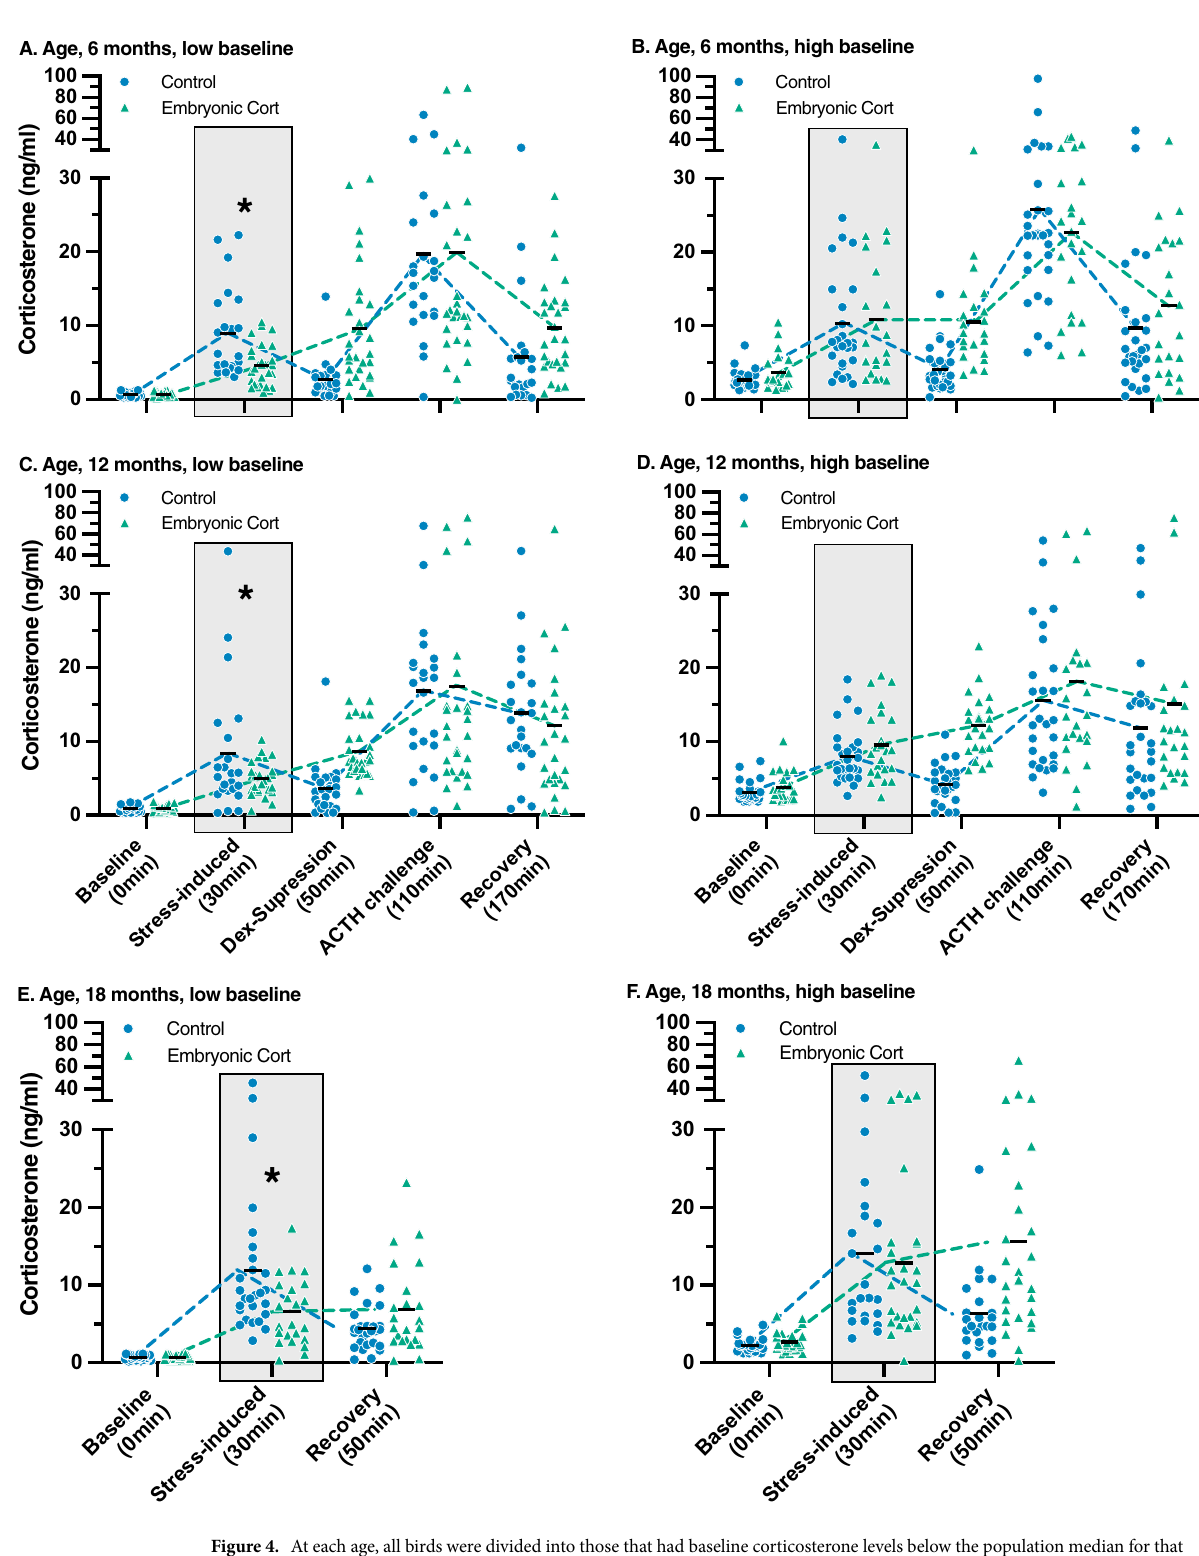
Figure 4. At each age, all birds were divided into those that had baseline corticosterone levels below the population median for that age and those with baseline corticosterone levels above the population median for that age (low vs. high, n = 25 per group). For both low and high baseline groups, corticosterone level is plotted for each component of the five-point HPA challenge at ( A , B ) 6 months and ( C , D ) 12 months, and the reduced three-point HPA challenge at ( E , F ) 18 months respectively. A gray box was placed over the stress-induced timepoint to more easily compare data between the low and high baseline groups and across the three ages. All control (blue circle) and 5 ng embryonic corticosterone (green triangle) individuals are represented. Black dashes represent group means and are connected by dashed lines for each treatment. Points are jittered for clarity of illustration. Significant differences in the effect of baseline by treatment interactions on the different stress challenge parameters are marked with an asterisk (Tukey HSD < 0.05). Because the majority of corticosterone values fell between 0 and 40 ng/ml, we split the y-axis at 40 ng/ml to more easily see the values between 0 and 40